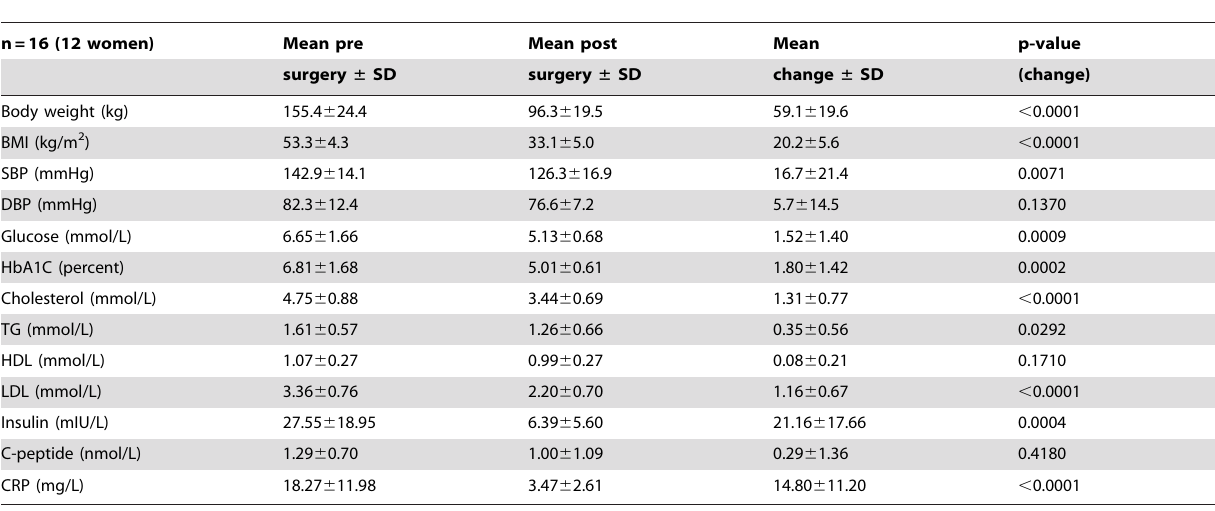
Table 1. Anthropometric and biochemical data of 16 subjects before and one year after bariatric surgery (BPD/DS).